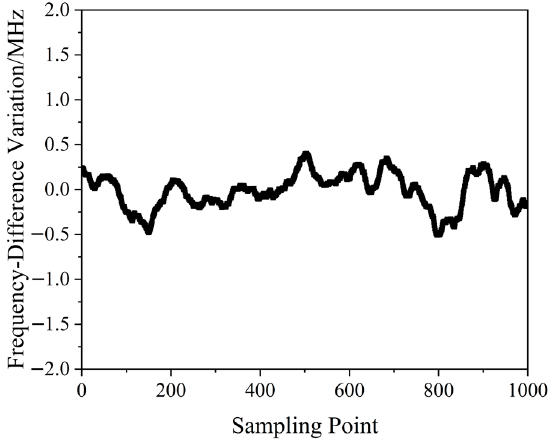
Figure 44. Frequency difference variation in the frequency-locked dual-frequency Nd:YAG laser [44]. Table 1. Comparison of experimental results of two QD-PDH frequency-difference-stabilizing sys- tems [44] .